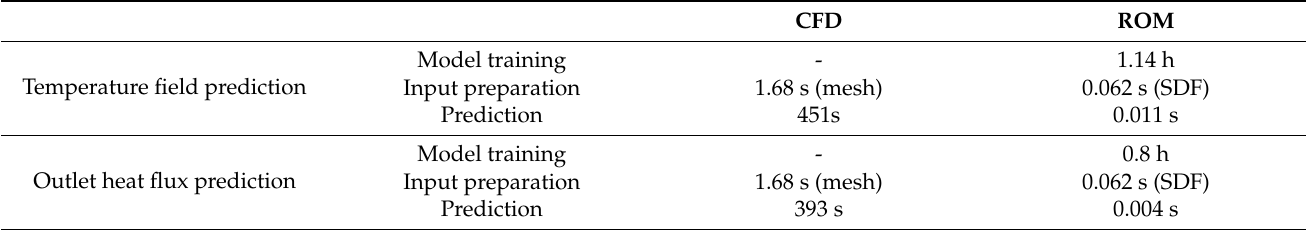
Table 5. Comparison of the time cost for temperature field and heat flux predictions by the proposed ROMs and the CFD simulation in OpenFOAM. CFD